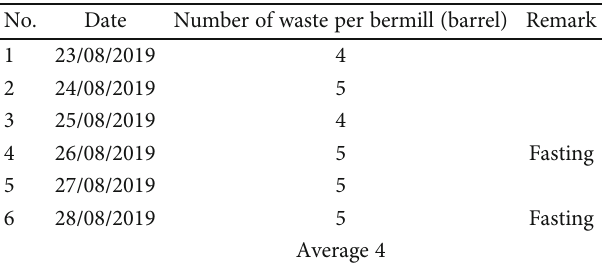
Table 5: Basic information on the physical properties of the substances [6].